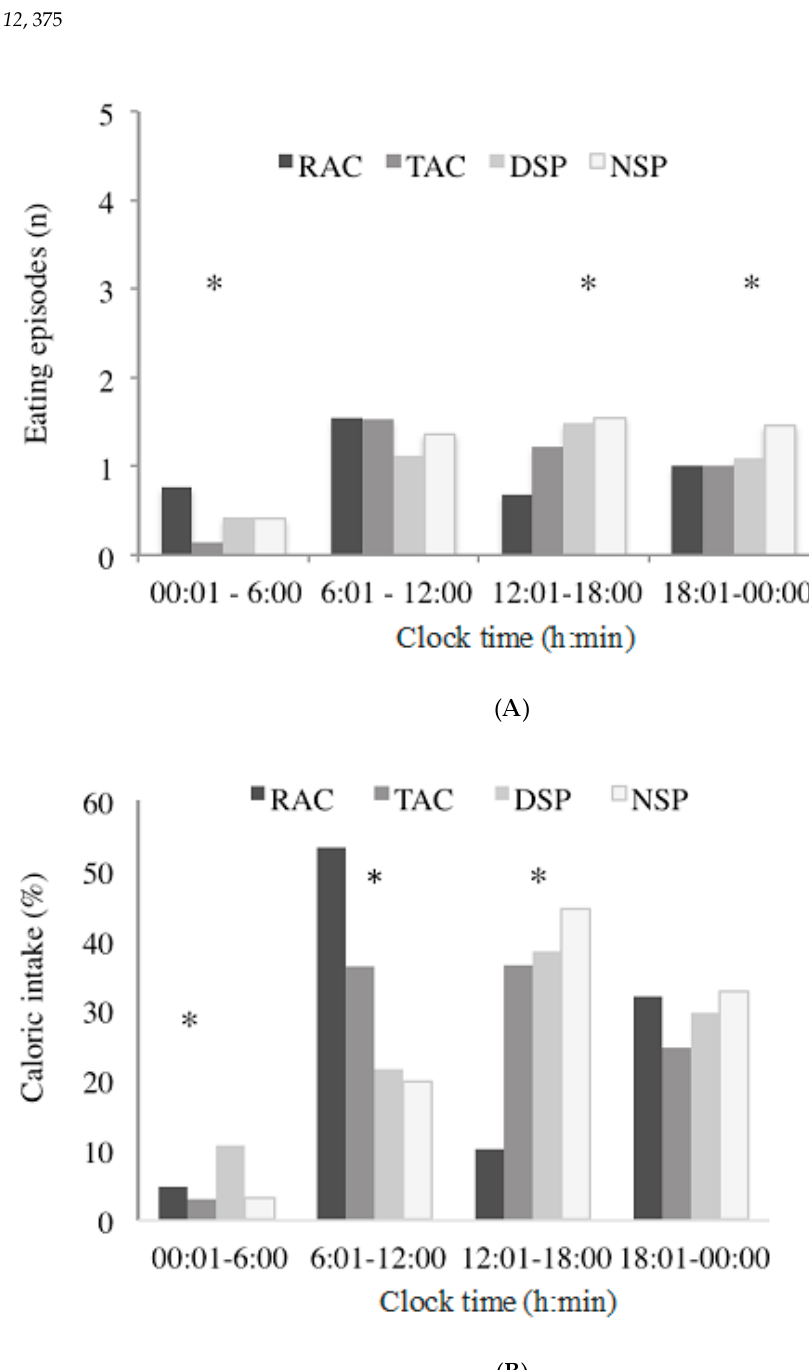
Figure 5. Number of eating episodes and calorie intake during different time periods among urban and rural workers in Acre and São Paulo. ( A ) number of eating episodes per day; ( B ) caloric intake (%) according to time of day. Eating episodes: 00:01–06:00 h (*KW p < 0.01); 12:01–18:00 h (*ANOVA p < 0.01); 18:01–00:00 h (*KW p < 0.01). Calorie intake: 00:01–06:00 h (*KW p < 0.01); 06:01–12:00 h (*ANOVA p < 0.01); 12:01–18:00 h (*KW p < 0.01).